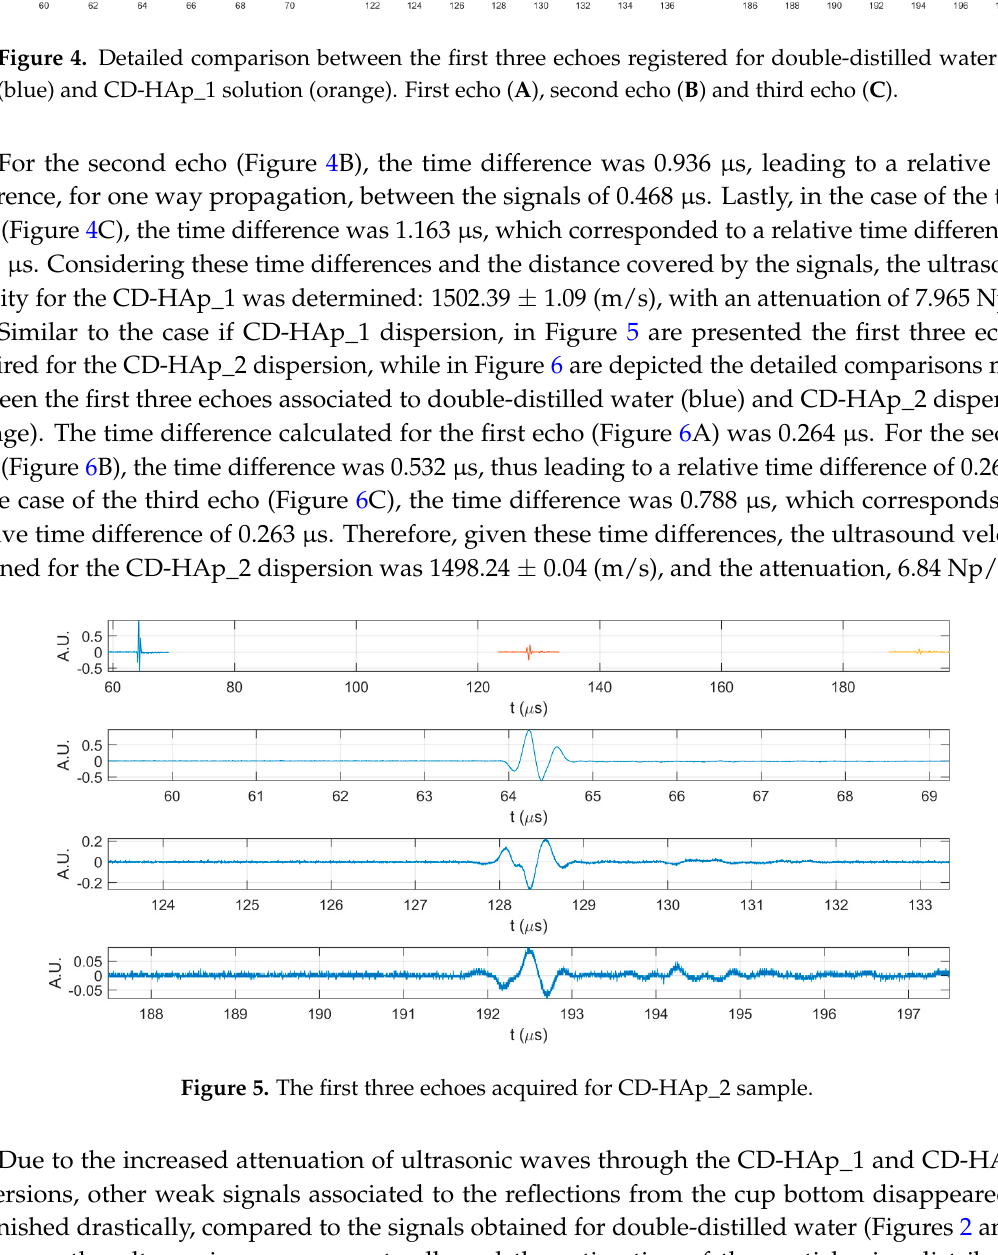
Figure 6. Detailed comparison between the first three echoes registered for double-distilled water (blue) and CD-HAp_2 solution (orange). First echo ( A ), second echo ( B ) and third echo ( C ).